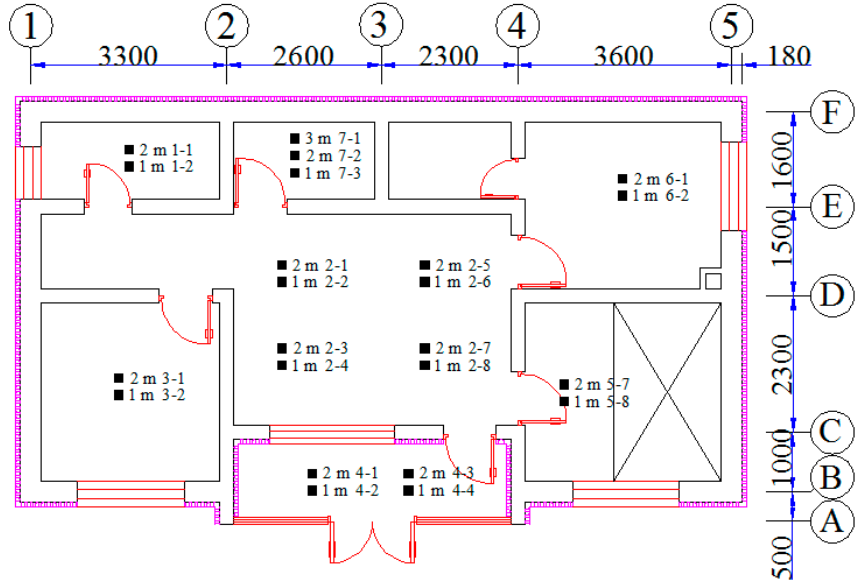
Figure 3. Floor plan of indoor measuring points.